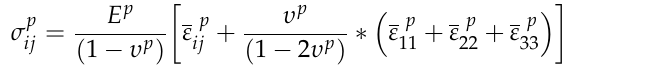
Table 2. Parameters applied for data evaluation. Young’s modulus and Poisson’s ratio for the austenite phase ( γ -Fe) according to [35] and for the ferrite phase ( α -Fe) according to [34]. γ {220} γ {222} γ {311} α {220} α {211} E { hkl } , p /MPa 212,758 259,167 177,329 219,911 219,911 E p /MPa 192,116 206,002 υ p /- 0.328